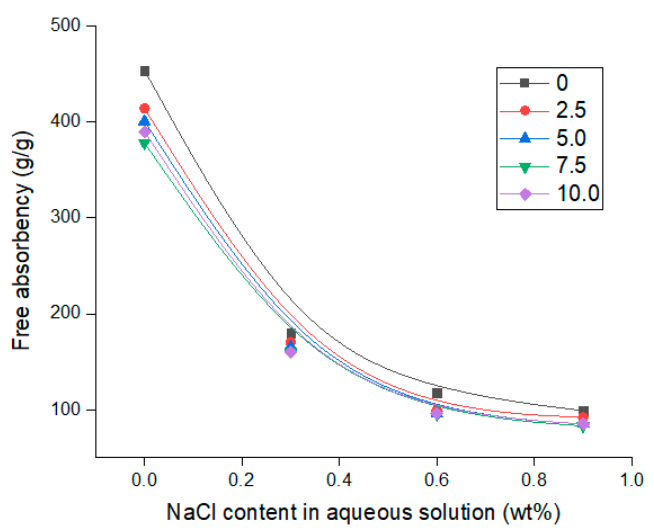
Figure 3. The free absorbency of the CSAP according to content of cellulose on various concentration of NaCl solution.